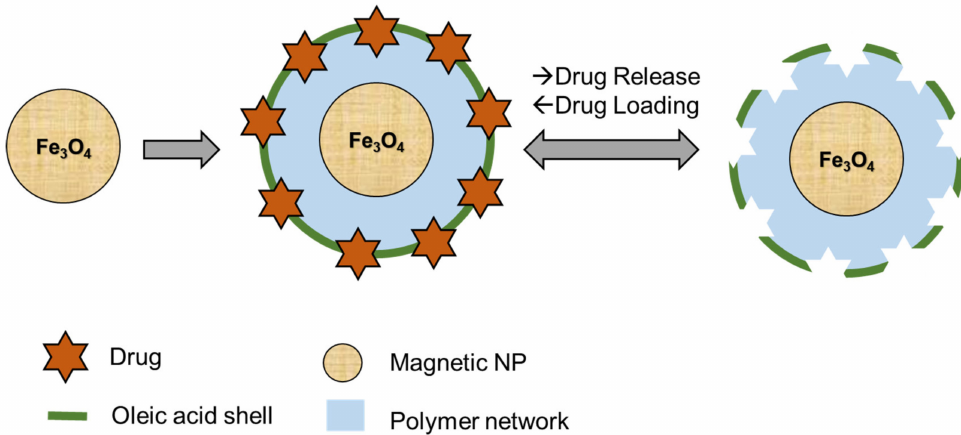
Figure 3. Scheme of the MMIPs preparation with an oleic acid topcoat The pre-polymerization mixture was obtained by the dissolution of the 1.0-mmol epirubicin (EPI) in 10 mL of DMSO and the addition of 9.0 mmol of functional monomer to this solution. The obtained mixture was then added to a suspension of 1.0 g Fe 3 O 4 nanoparticles (NPs) in 5 mL of DMSO and 20 mmol of ethylene glycol